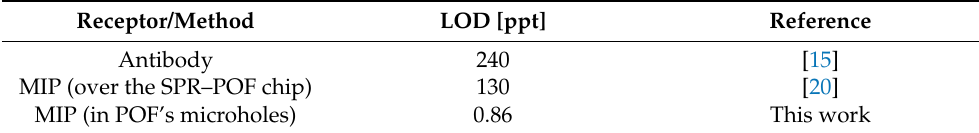
Table 5. A comparative analysis between PFOA sensors based on the same SPR–POF platform combined with different receptors and/or methods.